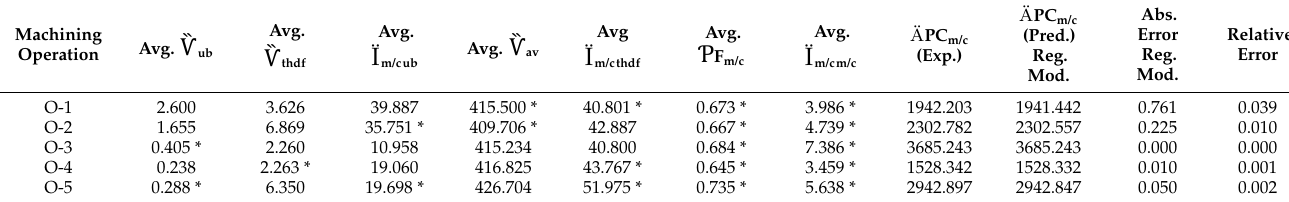
Table 12. Active power determined using regression equation and measured by power analyzer. Machining Operation